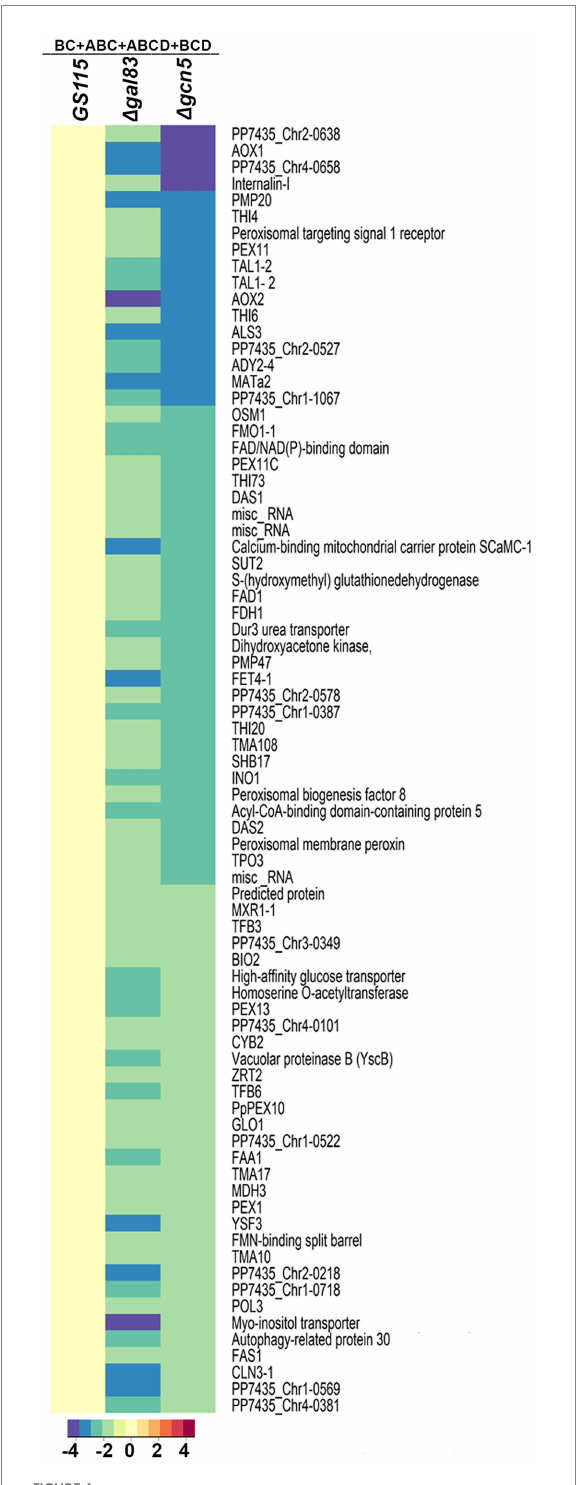
FIGURE 4 Heat map of genes downregulated in Δ gal83 and Δ gcn5